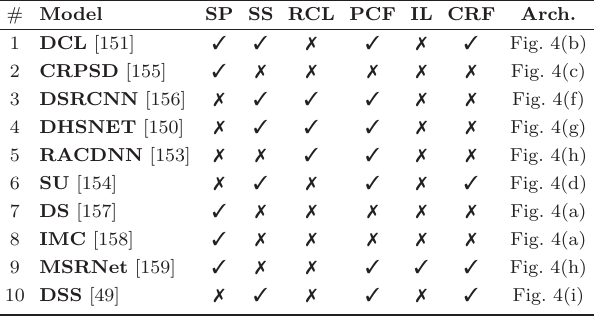
Table 5 Different types of information leveraged by existing FCN- based models. Abbreviations: SP: superpixel, SS: side supervision, RCL: recurrent convolutional layer, PCF: pure CNN feature, IL: instance-level, Arch: